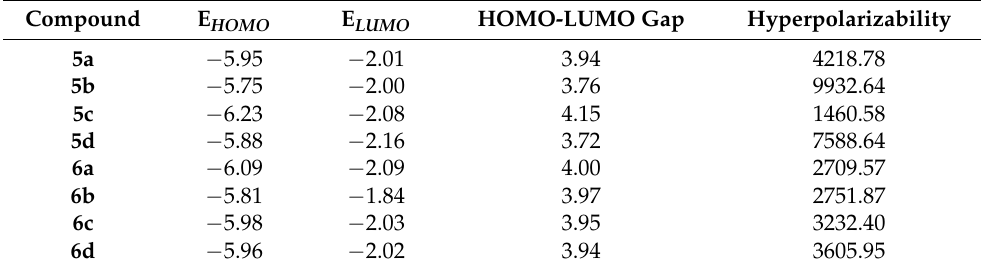
Table 1. HOMO, LUMO Energies and band gap. All the HOMO and LUMO energies are given in eV. Hyperpolarizability ( β ) values are given in